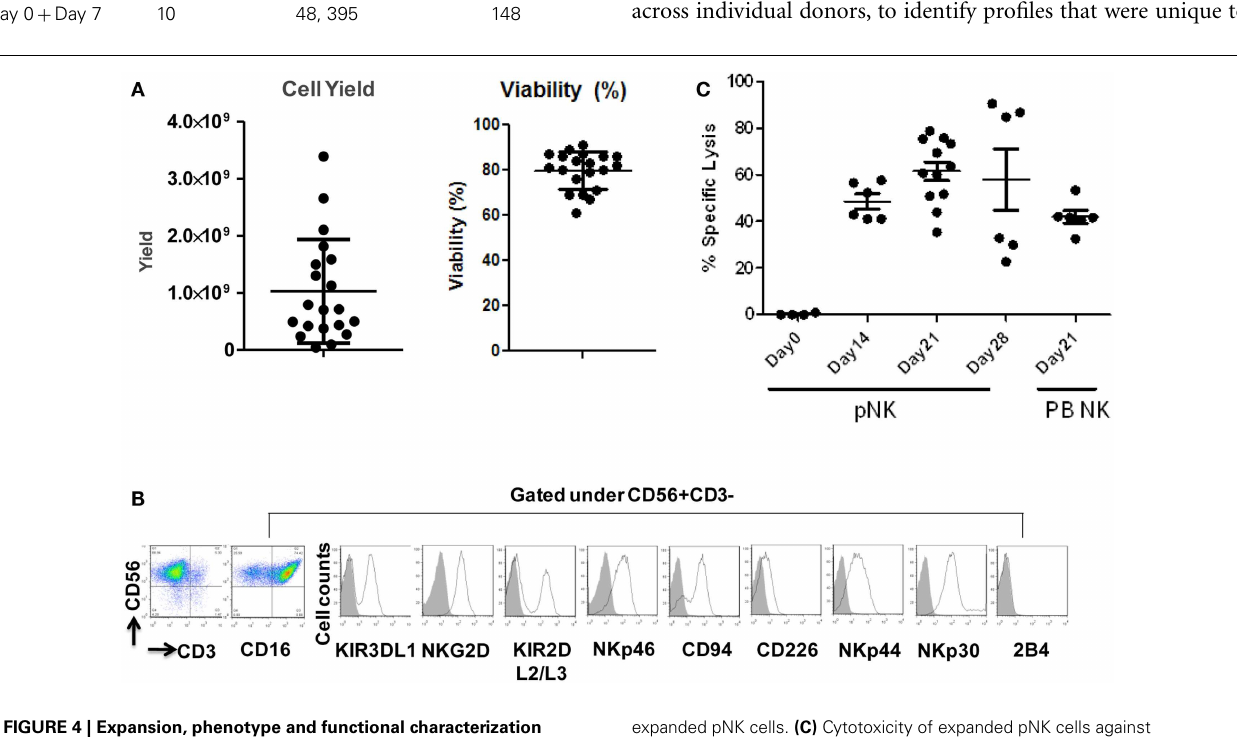
FIGURE 4 | Expansion, phenotype and functional characterization of ex vivo -expanded pNK cells . (A) Cell yield and cell viability of Day 21 expanded pNK cells. (B) Phenotype characterization of Day 21